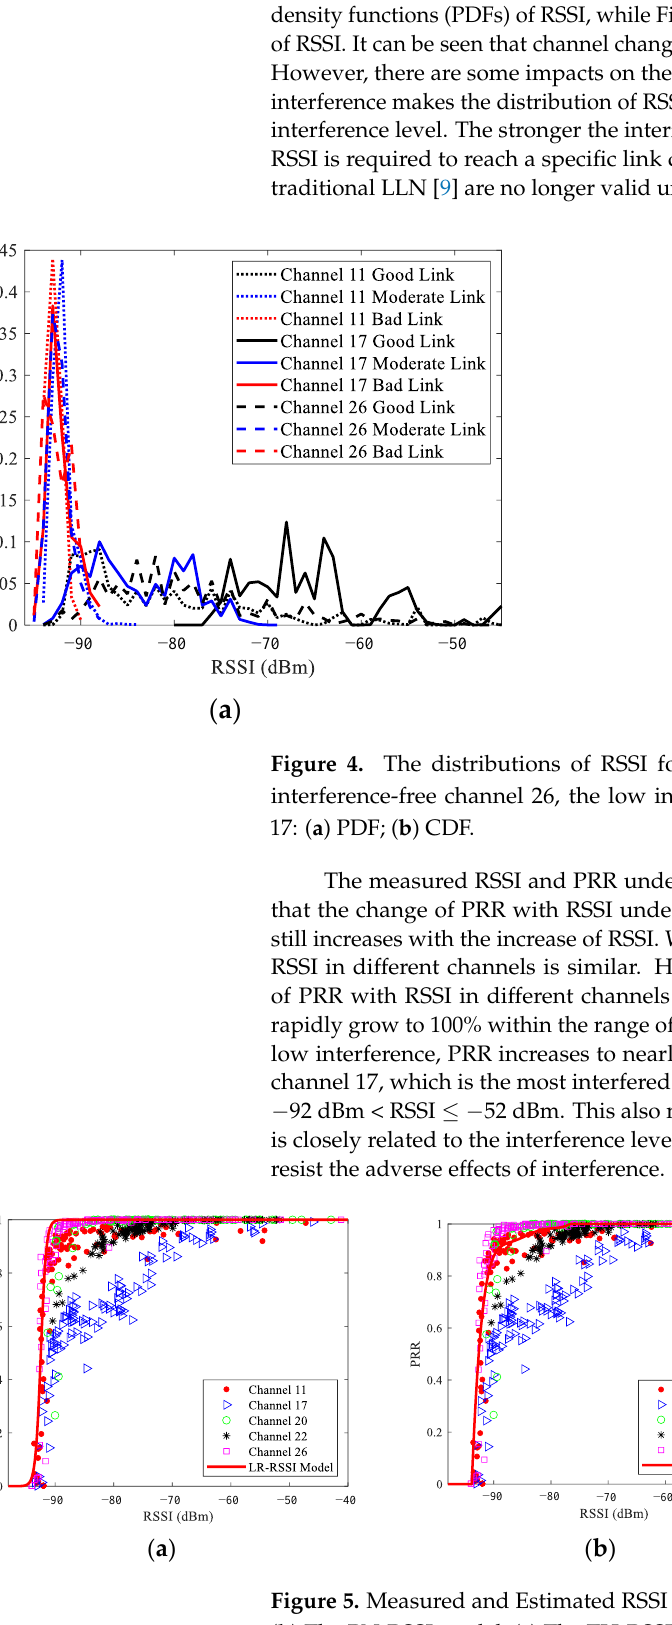
Figure 5. Measured and Estimated RSSI and PRR under different channels: ( a ) The LR-RSSI model; ( b ) The PN-RSSI model; ( c ) The TH-RSSI model. Next, the impact of channel changes on the models of RSSI and PRR is analyzed. For the mean noise required by the theoretical model, the measured data corresponding to each channel was used. For the normalized polynomial model, fitting using the measured data is not needed, as all the required parameters are constant. For the logistic regression model, the fitted parameters are c 1 = 223.2567, c 2 = 2.184, and c 3 = 196.4936. With these parameters, the curves of these models of RSSI and PRR under different channels can be obtained, as shown in Figure 5. Considering that the mean noises of channel 11 and 22 (also channel 20 and 26) are relatively close (as shown in Table 1), which makes the corresponding curves of the theoretical model nearly coincide, only the curves